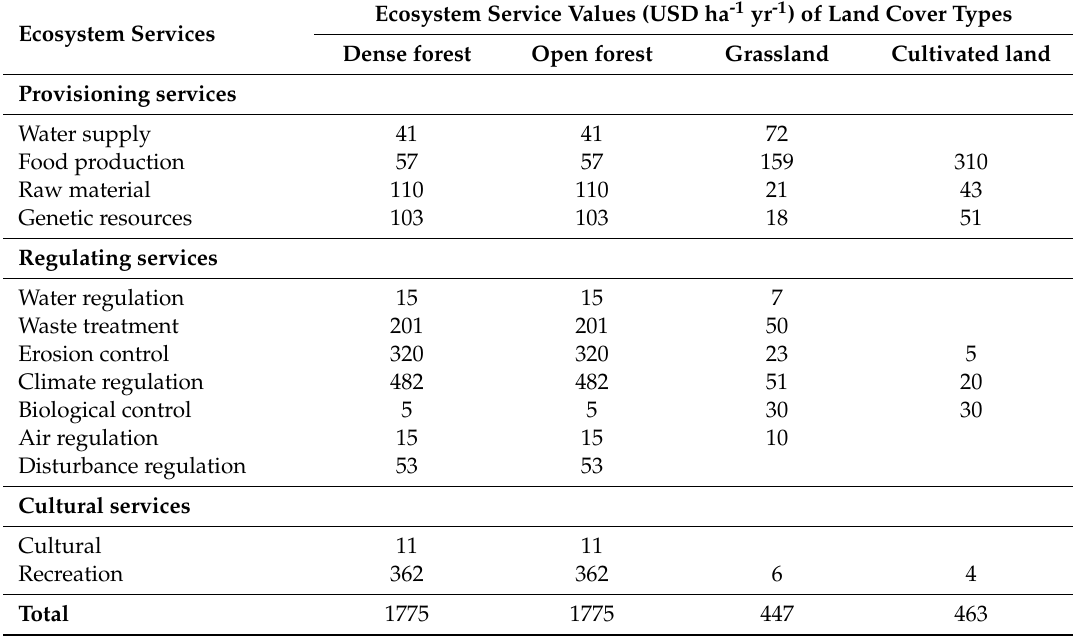
Table 4. Details of annual value coe ffi cients for ecosystem service functions of each land cover type. Ecosystem